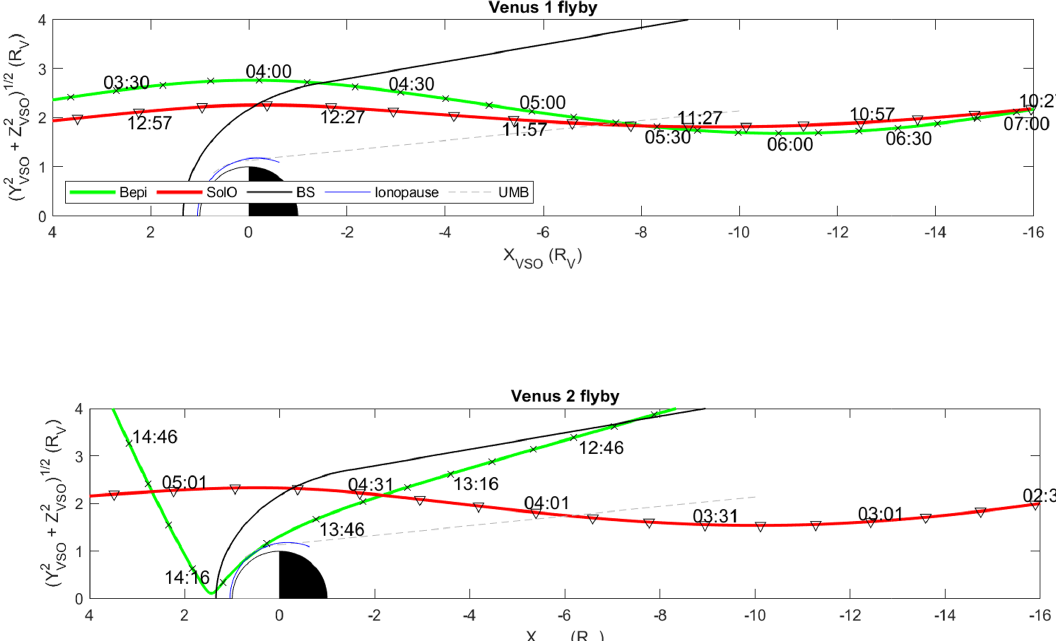
Figure 14. A comparison of the first and second Venus flybys by BepiColombo (green) and Solar Orbiter (red). The Venus 1 flyby was on 15 October 2020 for BepiColombo and on 27 December for Solar Orbiter. The Venus 2 flybys will take place on 9 August 2021 for Solar Orbiter and on 10 August for